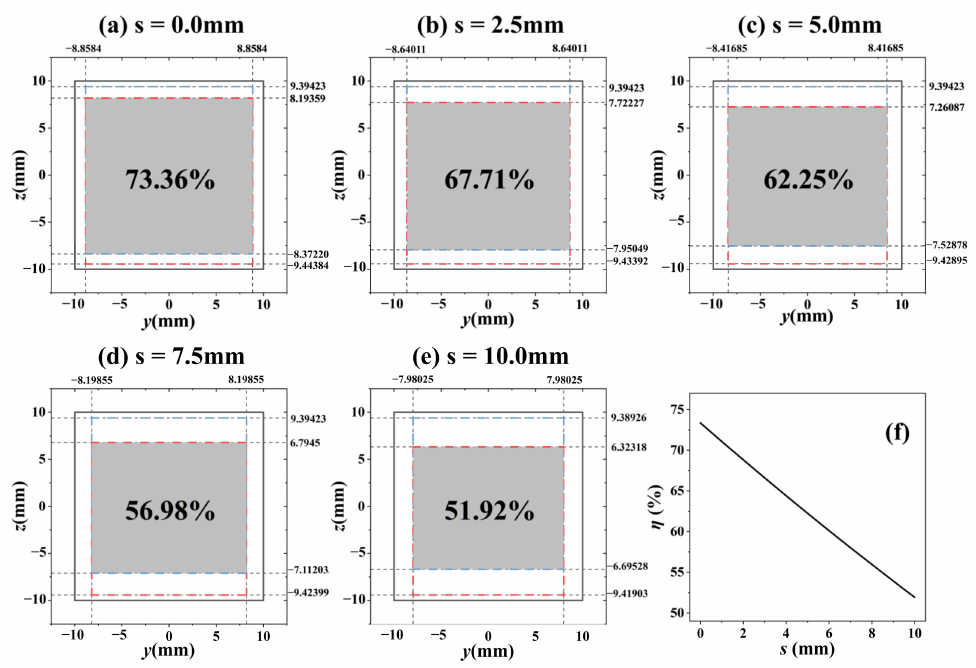
Figure 17. When FOV = 10 ◦ , s = 0–10 mm: ( a – e ) Aperture stop of DWP at different s ; ( f ) Variation in luminous flux utilization with